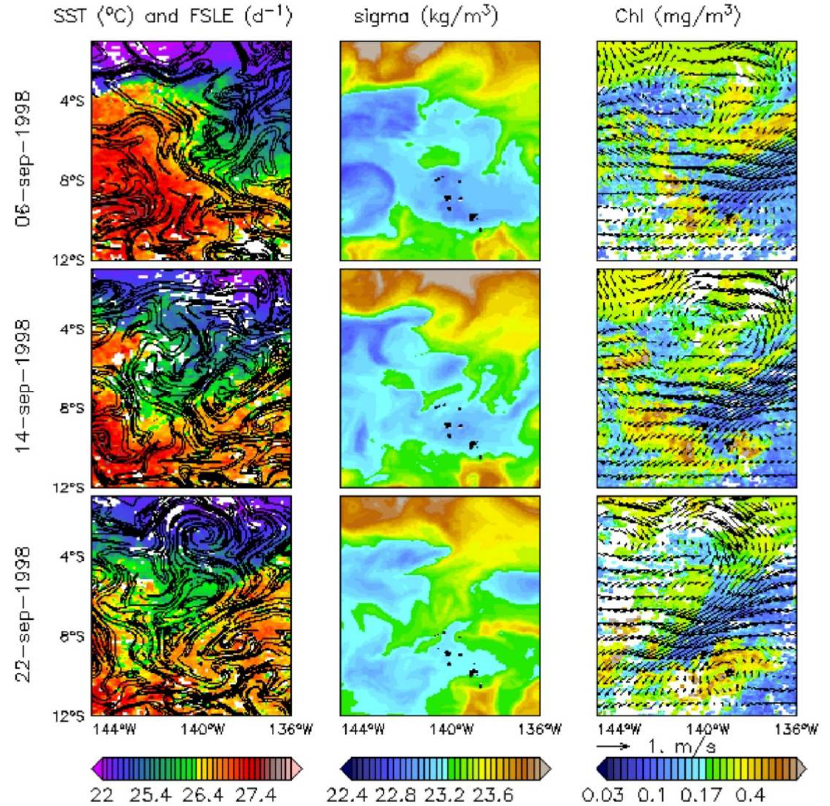
Figure 4. ( Left ) SST ( ◦ C) and FSLEs (d − 1 , isocontours are plotted from 0.07 to 1 every 0.1); ( Centre ) surface sigma (kg/m 3 ); ( Right ) Chl (mg/m 3 ) and surface current (m/s) on 6, 14, and 22 September 1998 (top to bottom, respectively). The islands are shown in black.